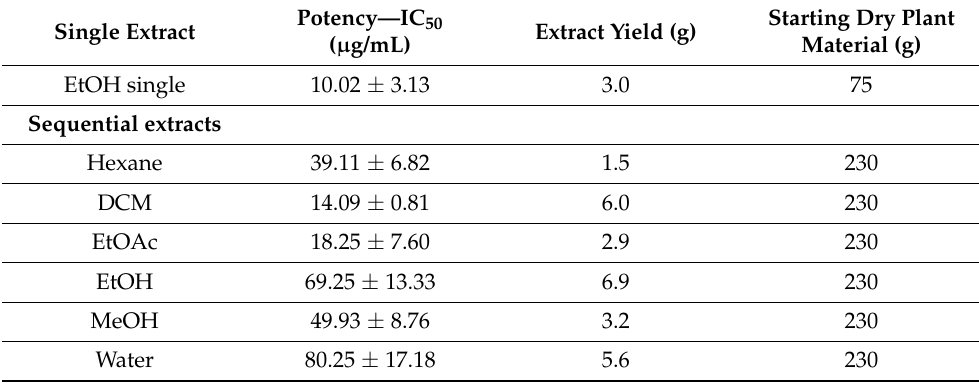
Table 1. Potency and yield/weight of Backhousia myrtifolia